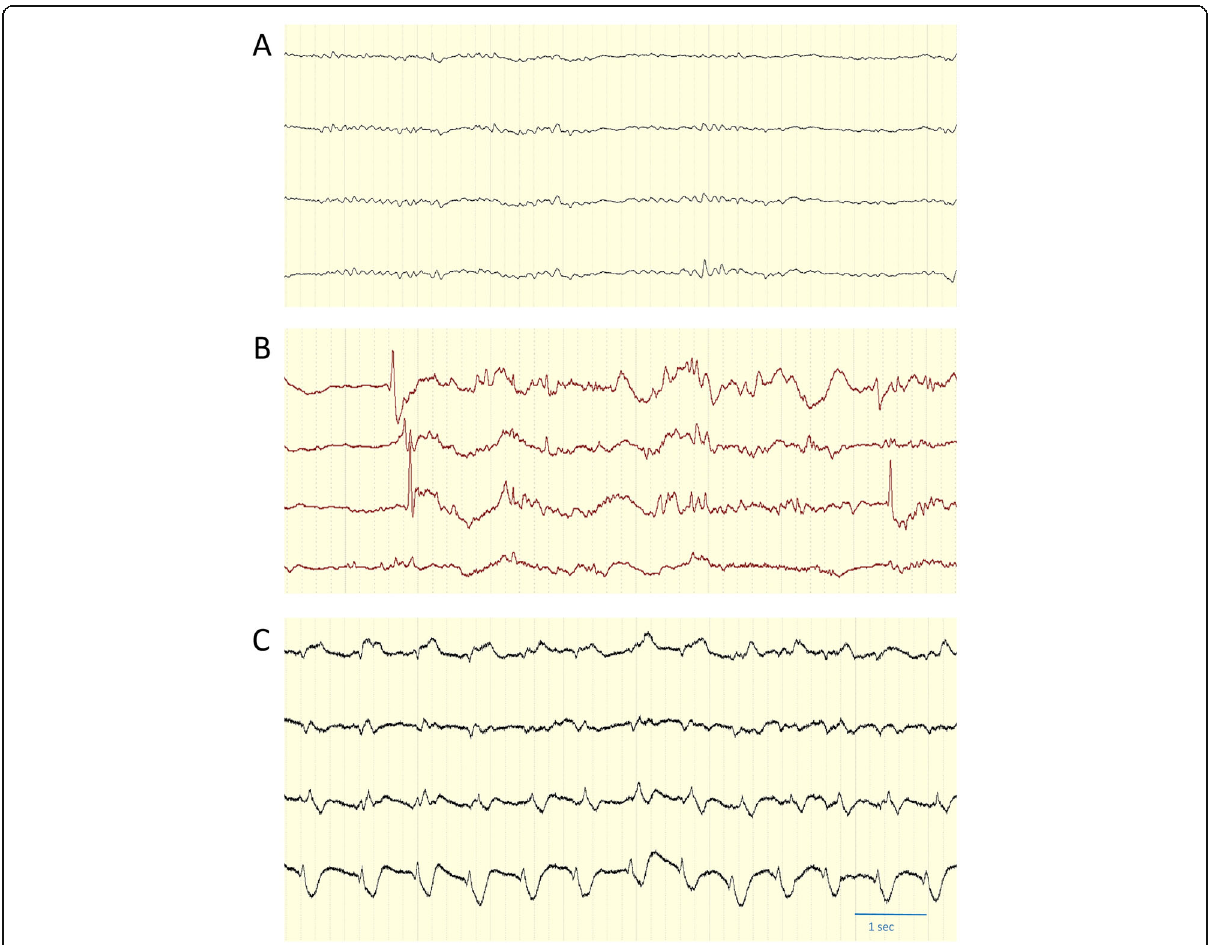
Fig. 4 Subdural four-channel EEG recording showing diffuse slowing ( a ), epileptiform discharges ( b ) and a continuous seizure pattern ( c